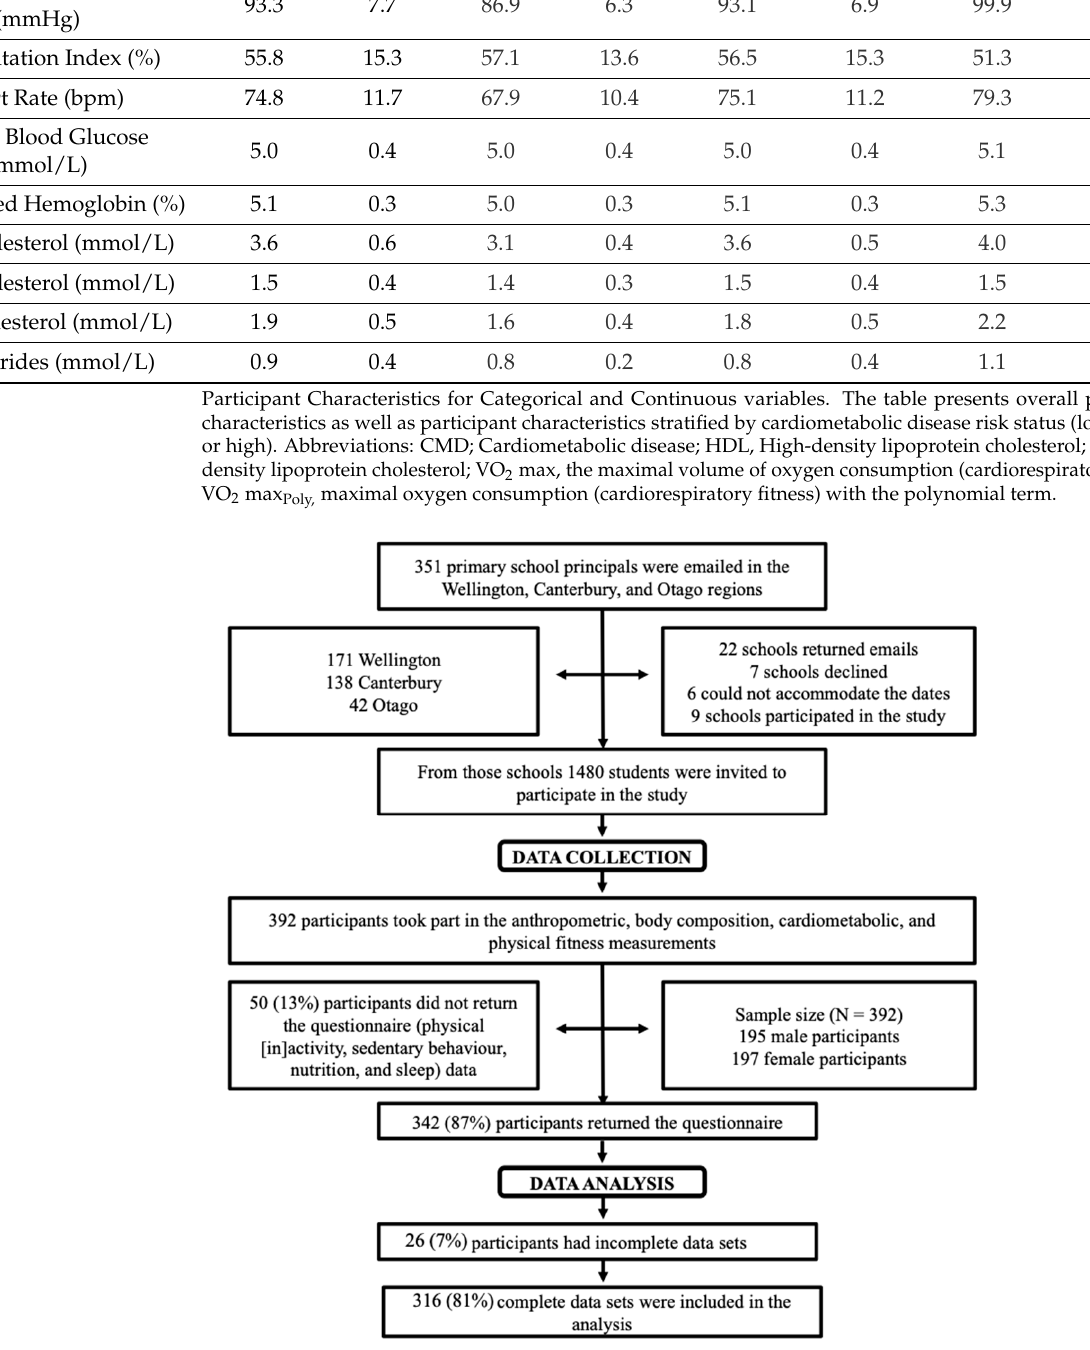
Figure 1. Flow Chart Showing Participant Recruitment and Study Timeline. Includes information regarding the time and location of recruitment, data collection, and